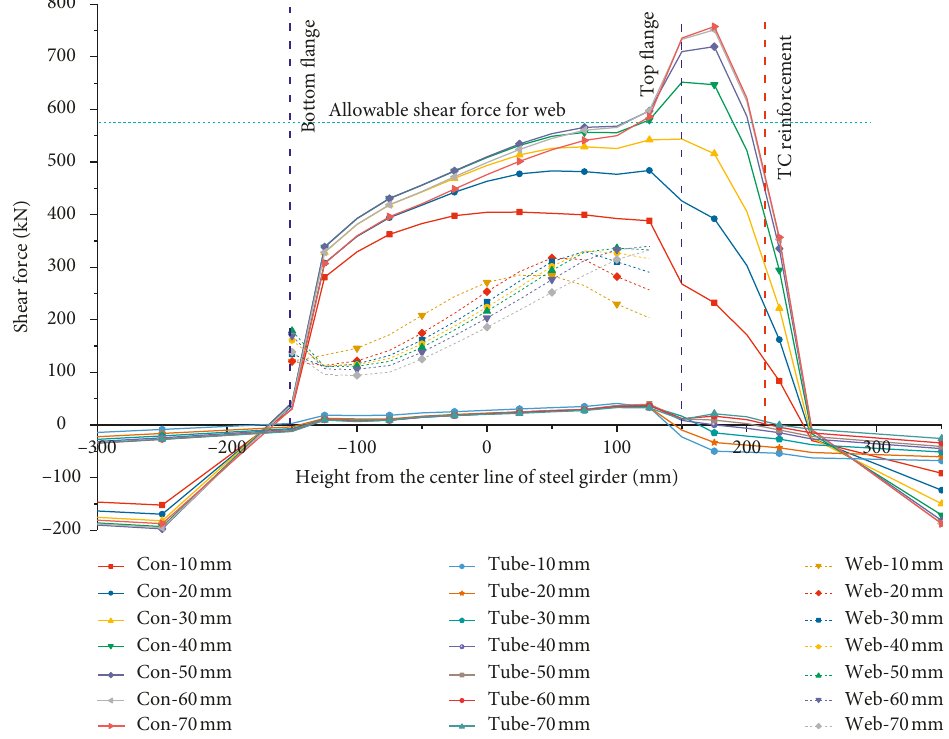
Figure 14: Shear force distribution of the joint components for